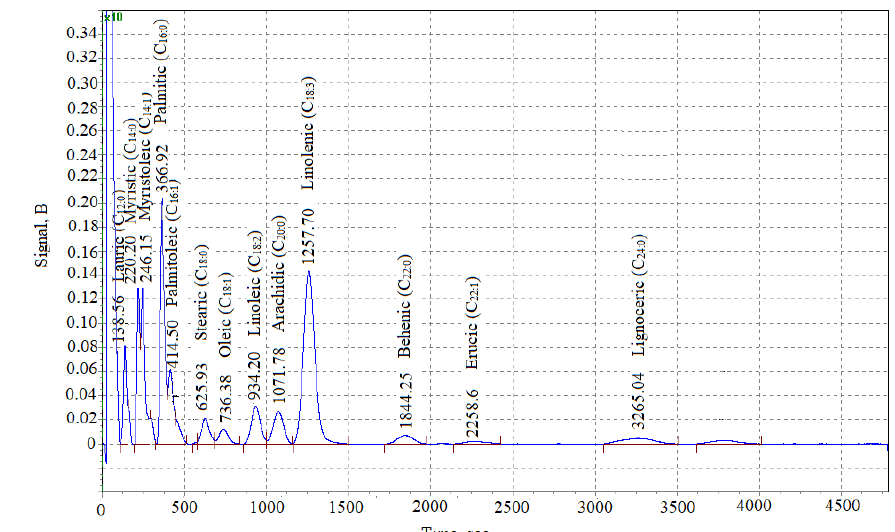
Fig. 5. Gas chromatogram of fatty acid composition in a lipophilic fraction of rye leaves (Khamarka